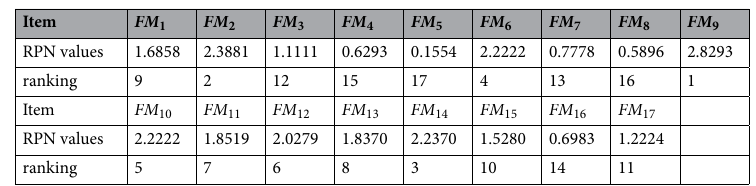
Table 10. The RPN values and ranking